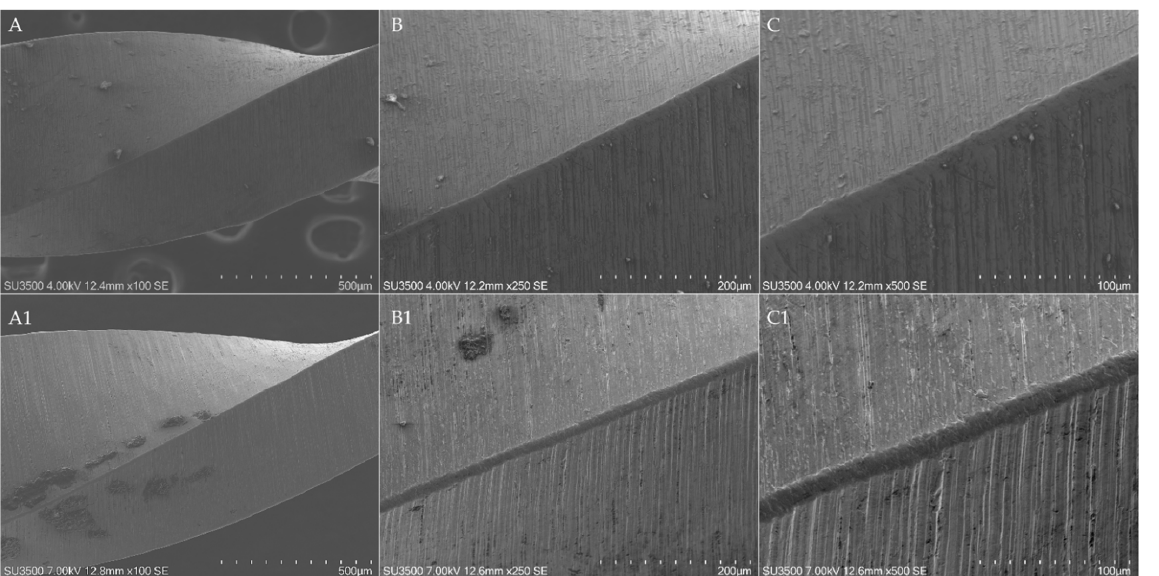
and 8, respectively (respectively, in the tip and 4, 8 and 12 mm from it).